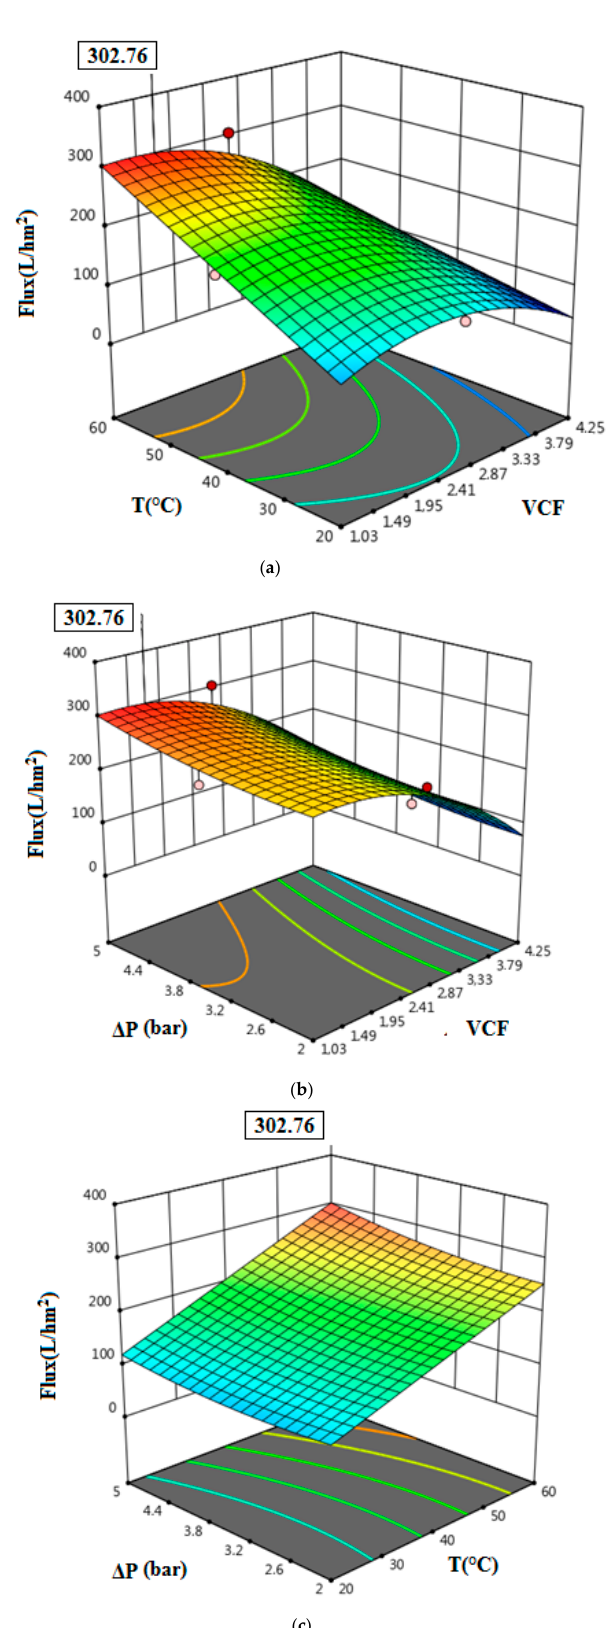
Figure 7. Response surface plots showing the effects of variables on protein removal: The interac- tion of VCF and T ( a ); the interaction of VCF and Δ P ( b ); the interaction of T and Δ P ( c ).